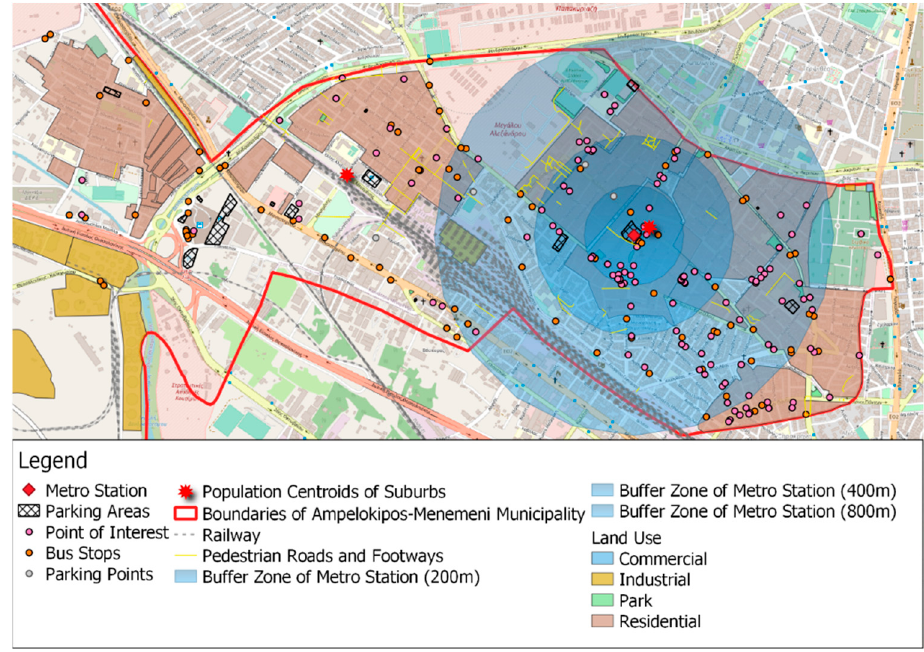
Figure 3. Buffer zones of 200 m, 400 m, and 800 m around the metro station (Background map: © OpenStreetMap contributors